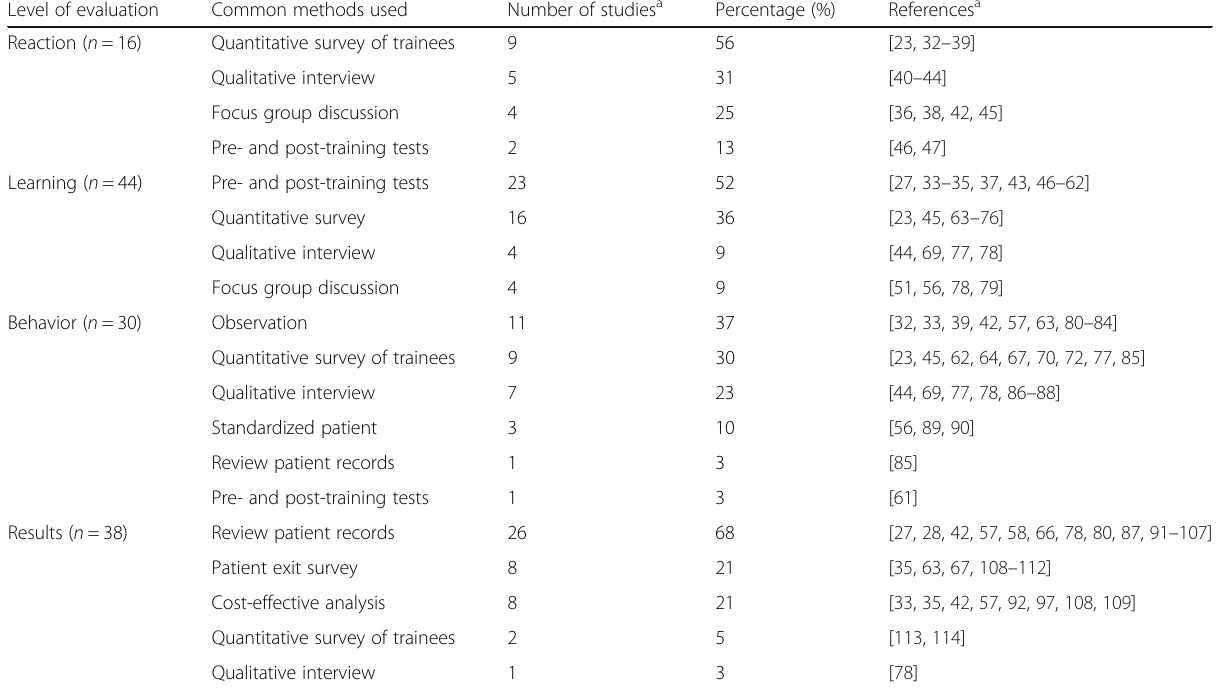
Table 5 Common evaluation methods for each level of the Kirkpatrick model Level of